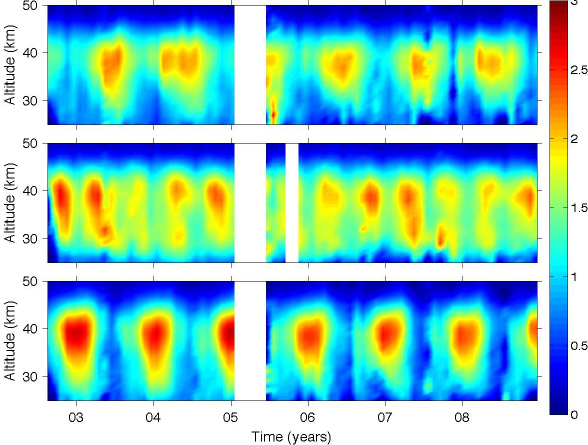
Fig. 23. Monthly NO 3 number density in the stratosphere in three latitude belts in 2002–2008 as a function of time and altitude. The density is scaled by 10 7 cm − 3 . The time covered is 1 August 2002– 31 December 2008. Latitude belts: 30 ◦ N–50 ◦ N (top), 10 ◦ S– 10 ◦ N (middle), 30 ◦ S–50 ◦ S